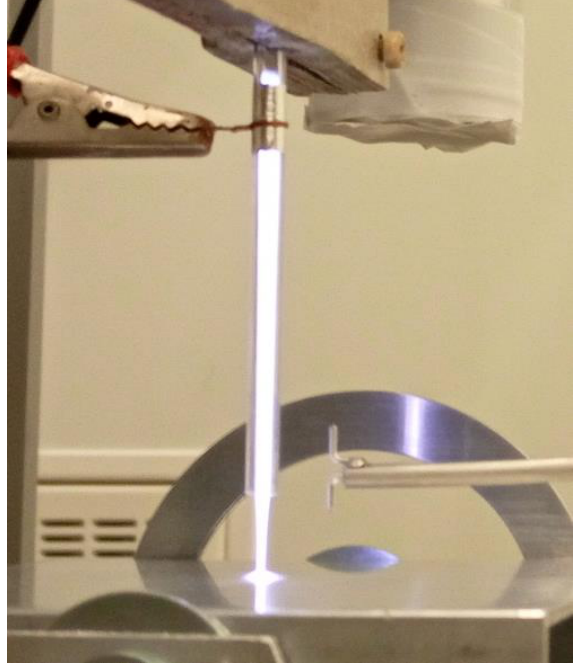
Figure 8. A typical configuration of the dipole antenna to detect the plasma discharge signal: measuring the electromagnetic field irradiated by the plasma.